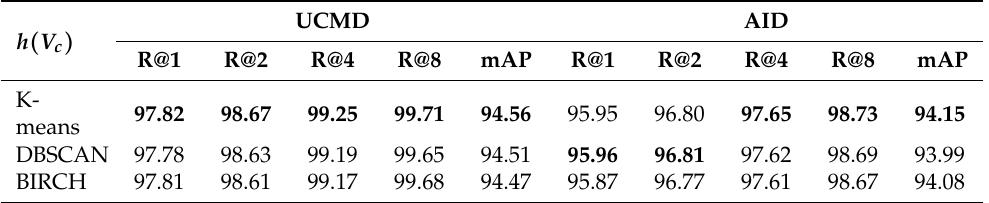
Table 2. Validation of the cluster algorithm on UCMD and AID. The best results are shown in bold. h ( V c )